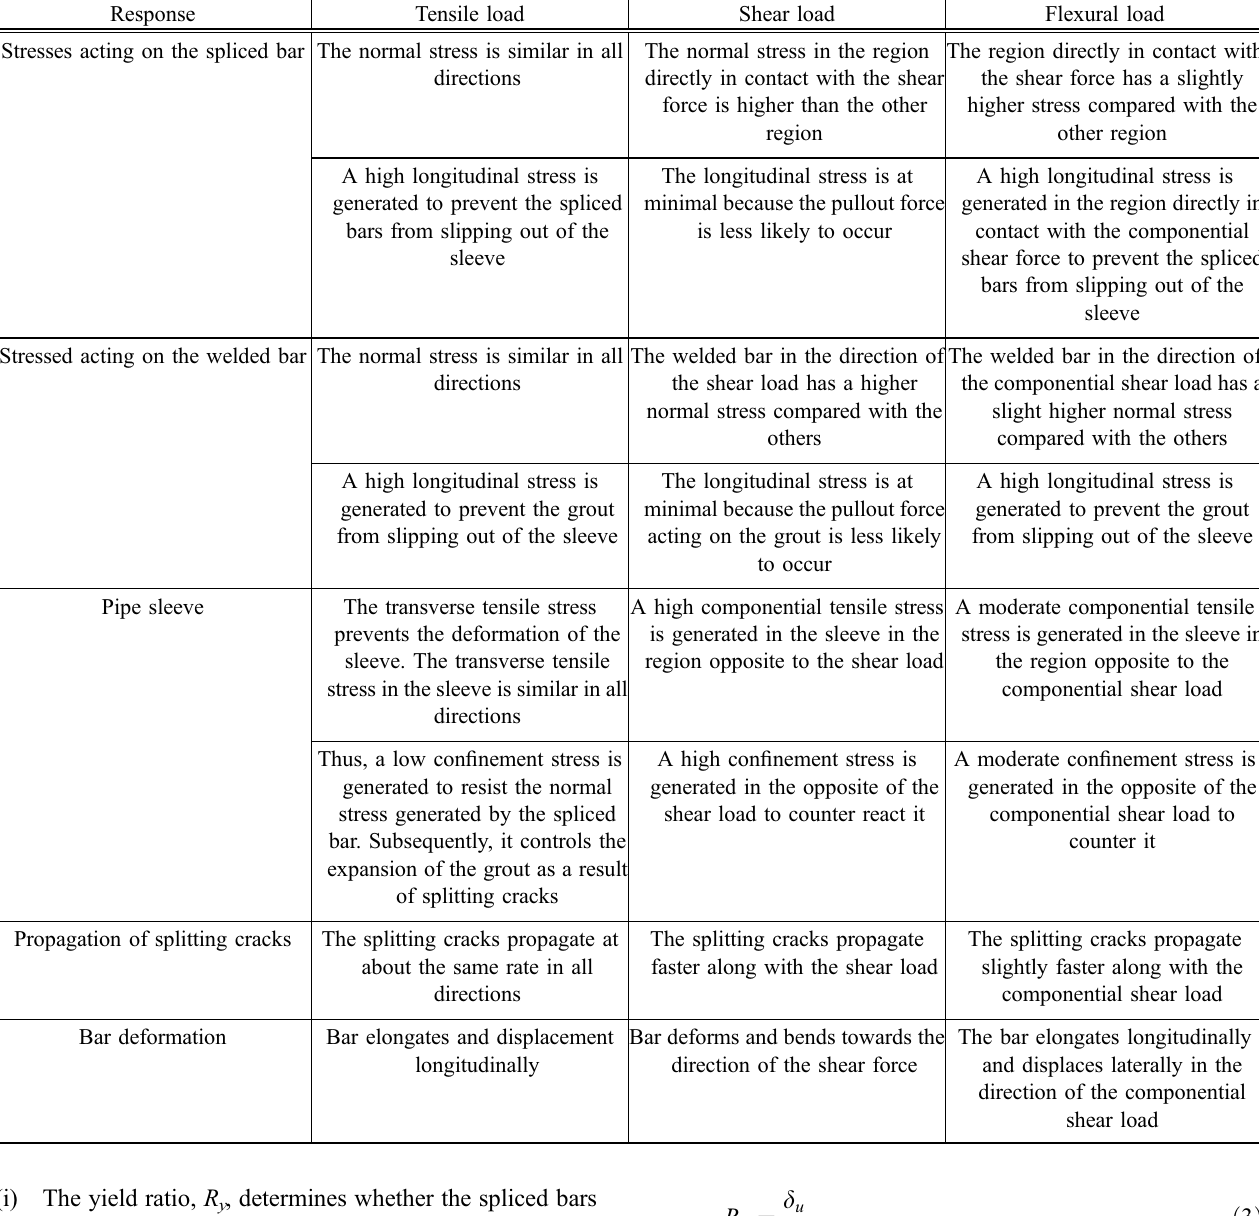
Table 6 Comparison of the response of WBS under different load